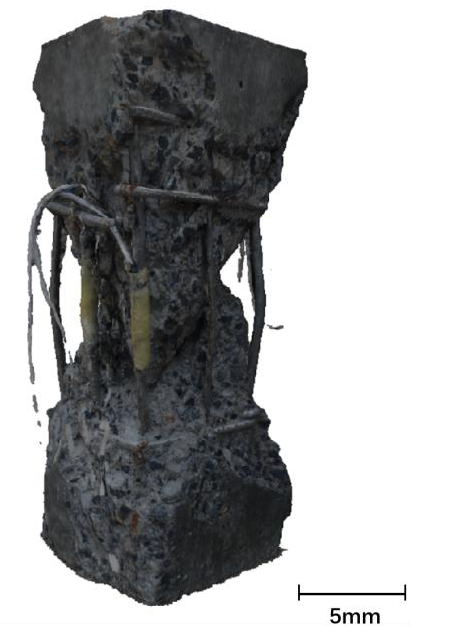
Figure 5. Images from each step of the 3D reconstruction process. ( a ) Sparse point cloud image; ( b ) dense point cloud image; ( c ) Poisson surface reconstruction image; ( d ) texture-mapped image.